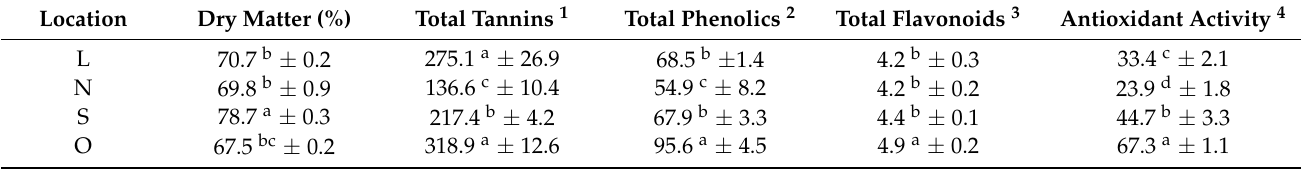
Table 1. Content of secondary metabolites in healthy leaves on the first harvest